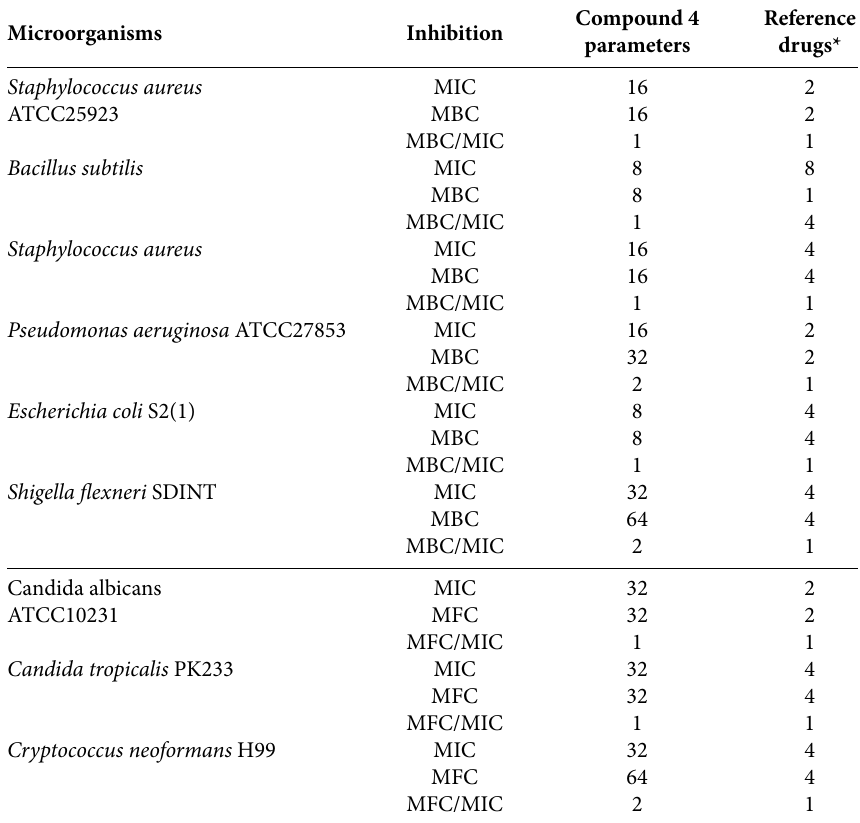
Table 4. Antimicrobial activity (MIC, MBC and MFC in µg/mL) of compound complex against bacte- rial and yeast species Microorganisms